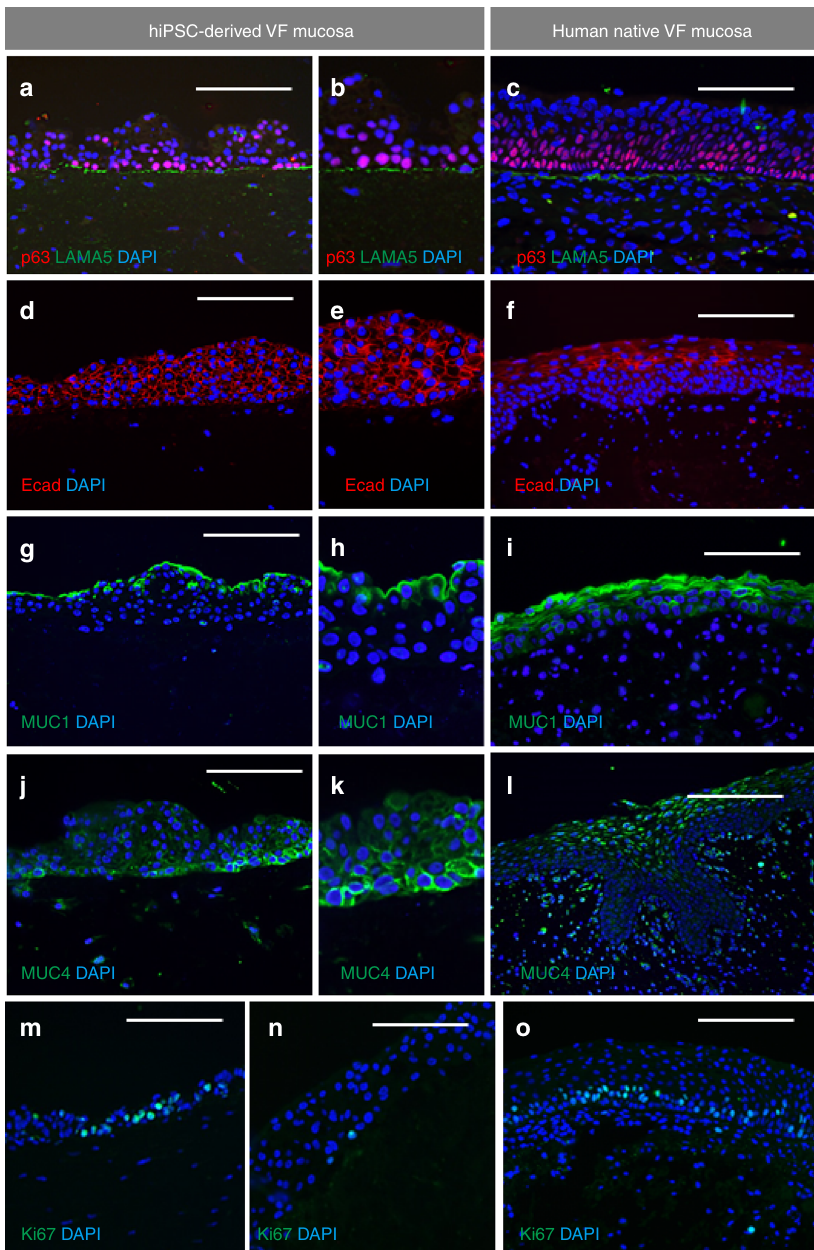
Fig. 7 Characterization of structural and functional genes expressed in the hiPSC-derived VF mucosa. a – c Double immuno fl uorescent staining for expression p63 (red) and Laminin alfa 5 (green) showing that hiPSC-derived VFEC form a basement membrane ( a , b ) similar to VFEC in human native VF mucosa ( c ). d – f Immuno fl uorescent staining comparing the expression pattern of E-Cadherin (red) in hiPSC-derived VF mucosa ( d , e ) and human native VF mucosa ( f ). g – i Immuno fl uorescent staining comparing the expression pattern of MUC1 (green) in hiPSC-derived VF mucosa ( g , h ) and human native VF mucosa ( i ). j – l Immuno fl uorescent staining comparing the expression pattern of MUC4 (green) in hiPSC-derived VF mucosa ( j , k ) and human native VF mucosa ( l ). m – o Immuno fl uorescent staining comparing intensity of cell proliferation, anti-Ki67staining (green), in hiPSC-derived VF mucosa ( m , n ), and human native VF mucosa ( o ). Scale bar = 200 μ m. hiPSC human induced pluripotent stem cell, VF vocal